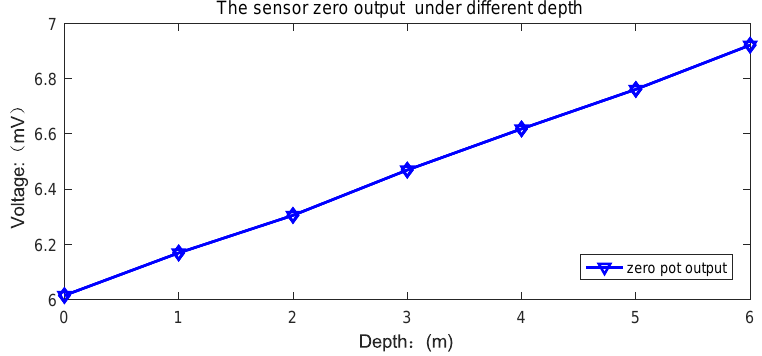
Figure 15. Zero output voltage at different